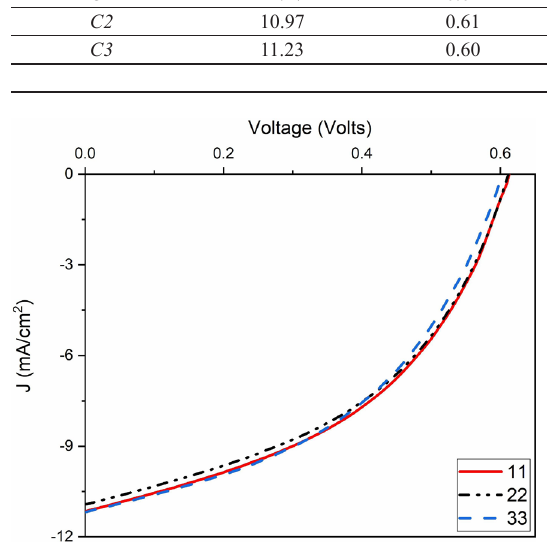
Figure 10. External quantum efficiency of the device fabricated with the configuration of FTO/TiO /P3HT:PC BM/MoO /Ag . 2 61 3